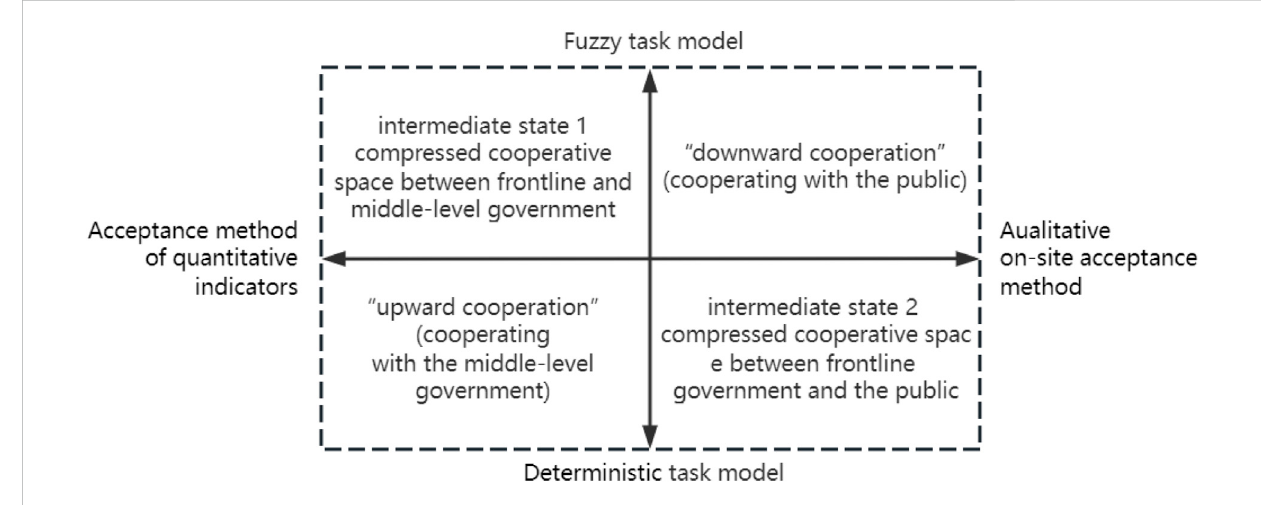
FIGURE 2 Analytical framework of institutional dynamic path.